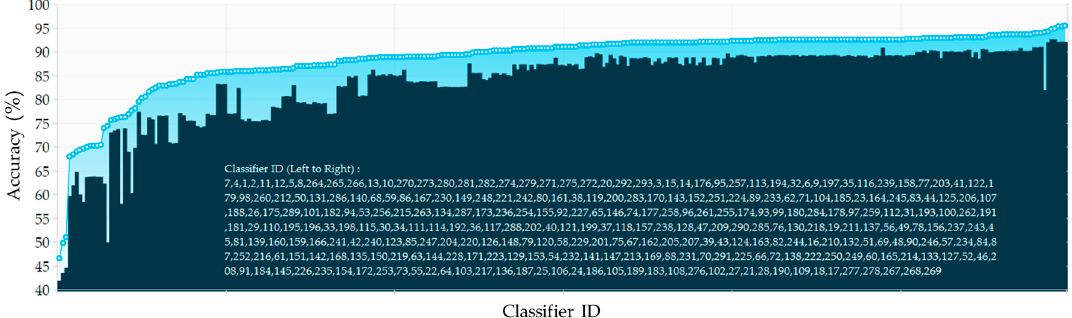
Figure 4. The minimum and maximum accuracy of each classifier over different window sizes, ranging from 1 s to 15 s, with the waist accelerometer data.